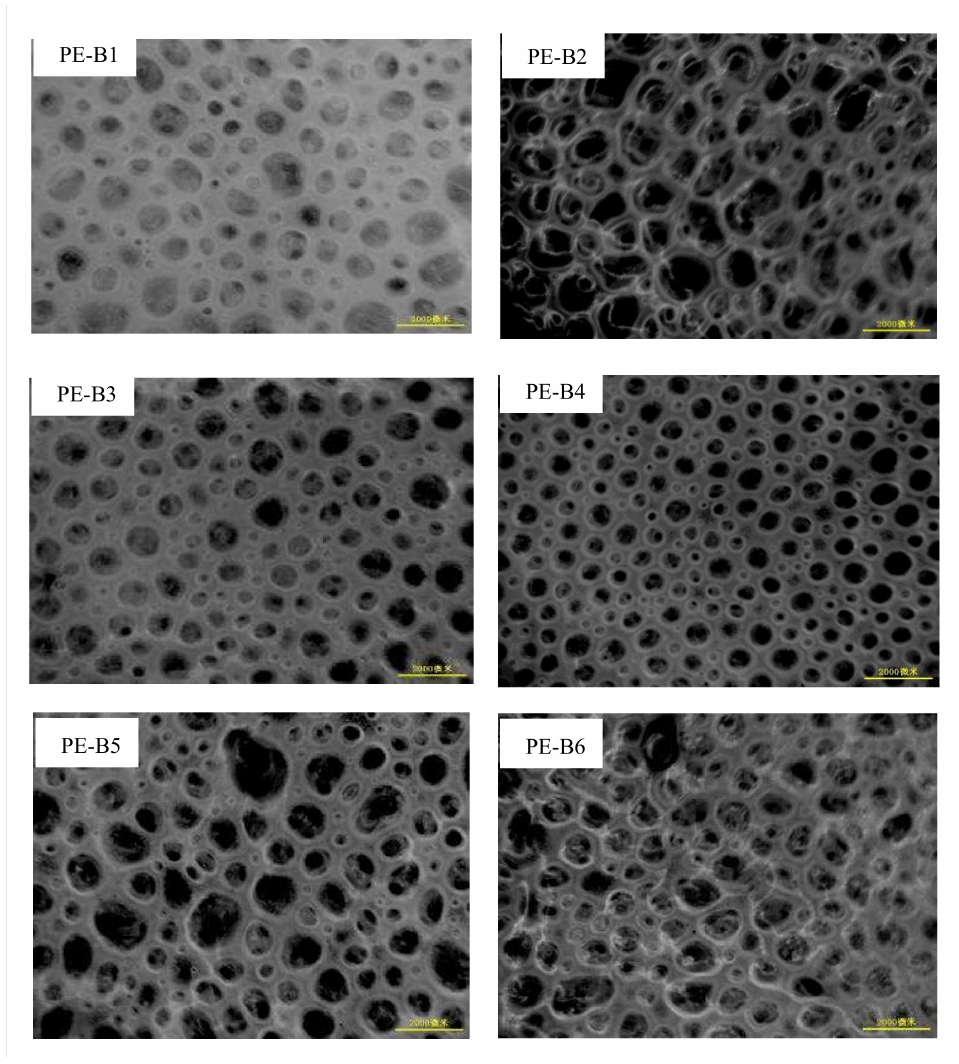
Figure 5. Cells morphology of foamed